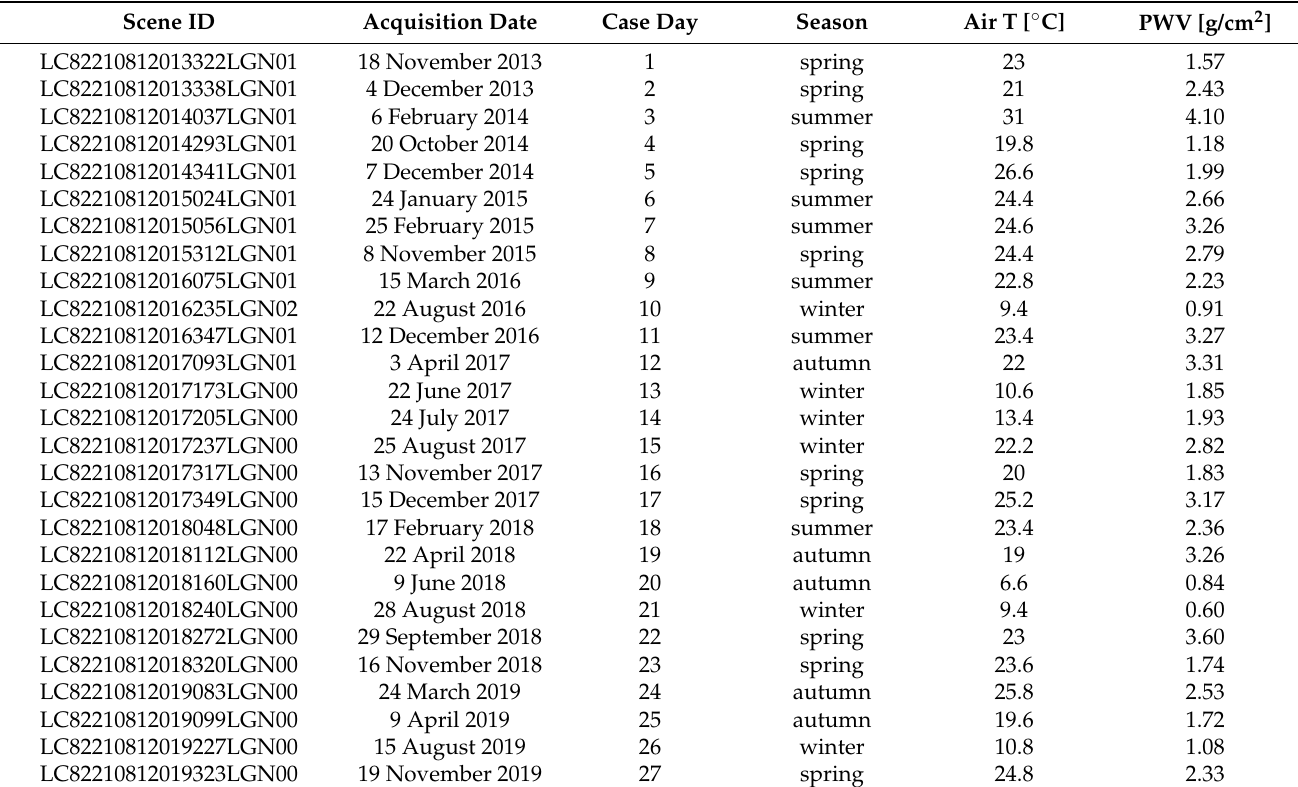
Table 1. Information about Landsat 8 data used in the paper (27 images from 2013 to 2019, Path-Row 221-81). The last columns present meteorological conditions measured by the SBPA